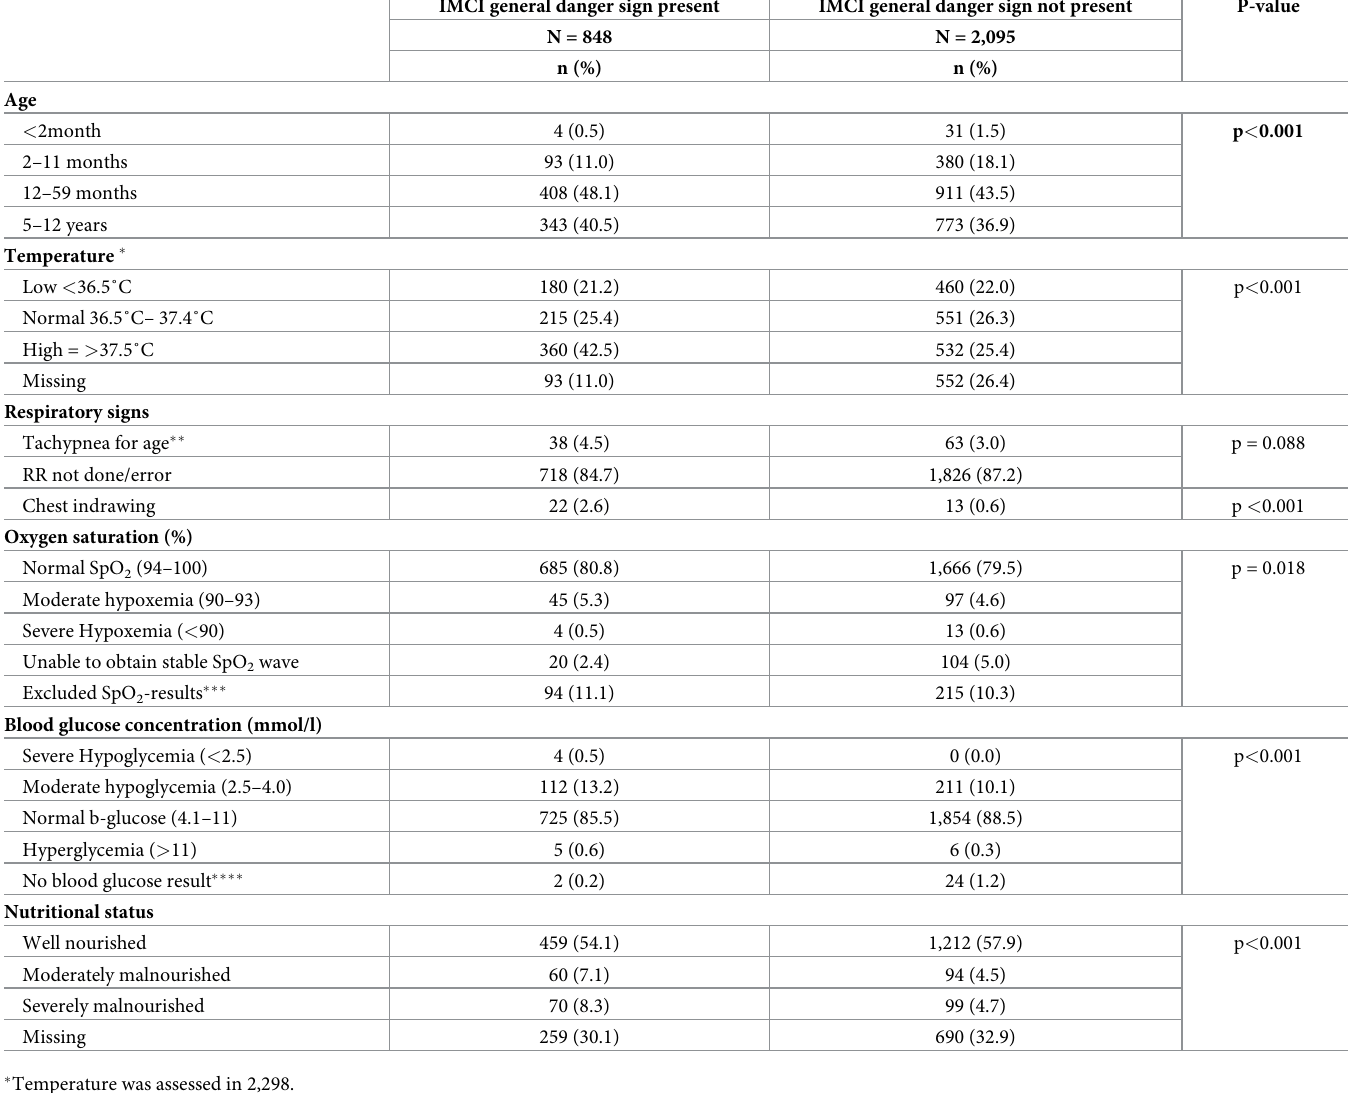
Table 4. Clinical characteristics by presence of any IMCI danger